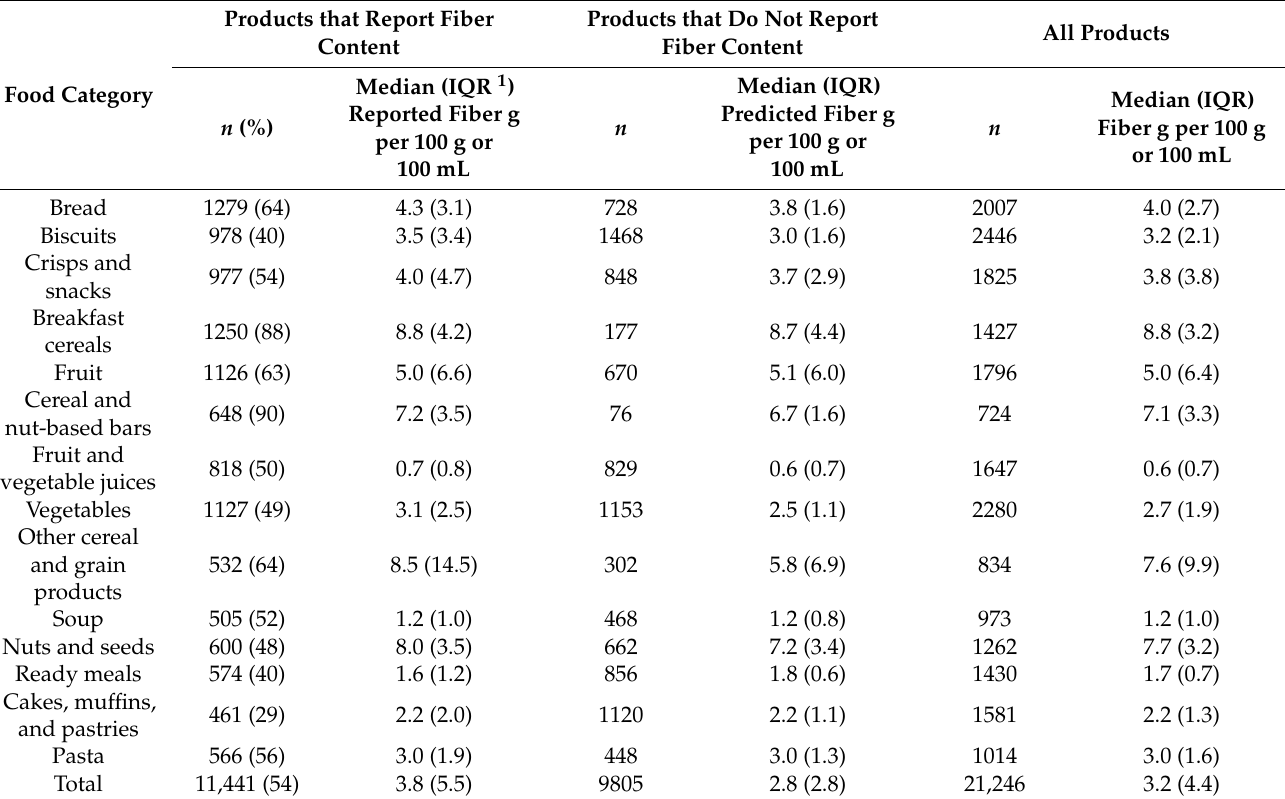
Table 1. Fiber in the Australian packaged food